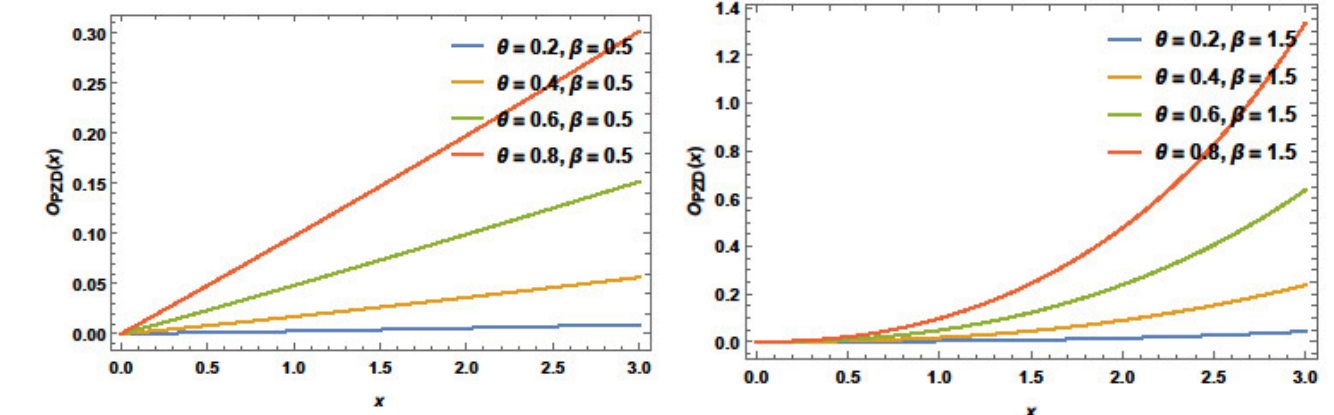
Figure 7. The odds function plots of PZD for selected values of parameters. Mean residual life (MRL) is crucial in demography, reliability, and survival analysis.